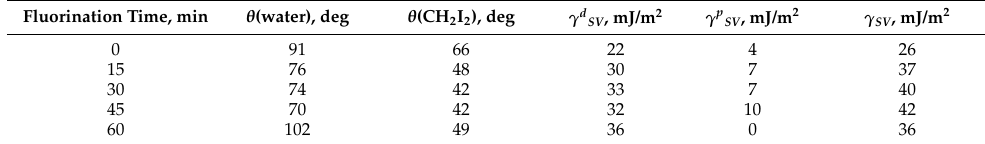
Table 2. Characteristics of the surface of PVTMS films depending on the time of fluorination. Fluorination Time, min θ (water),